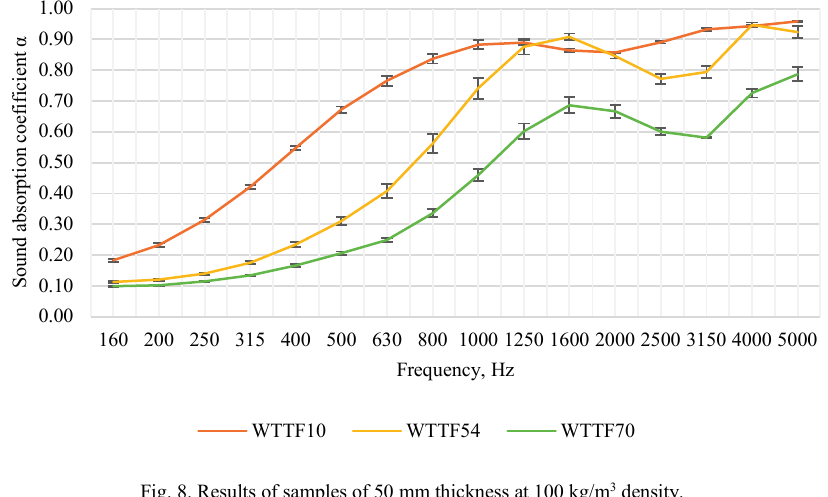
Fig. 8. Results of samples of 50 mm thickness at 100 kg/m 3